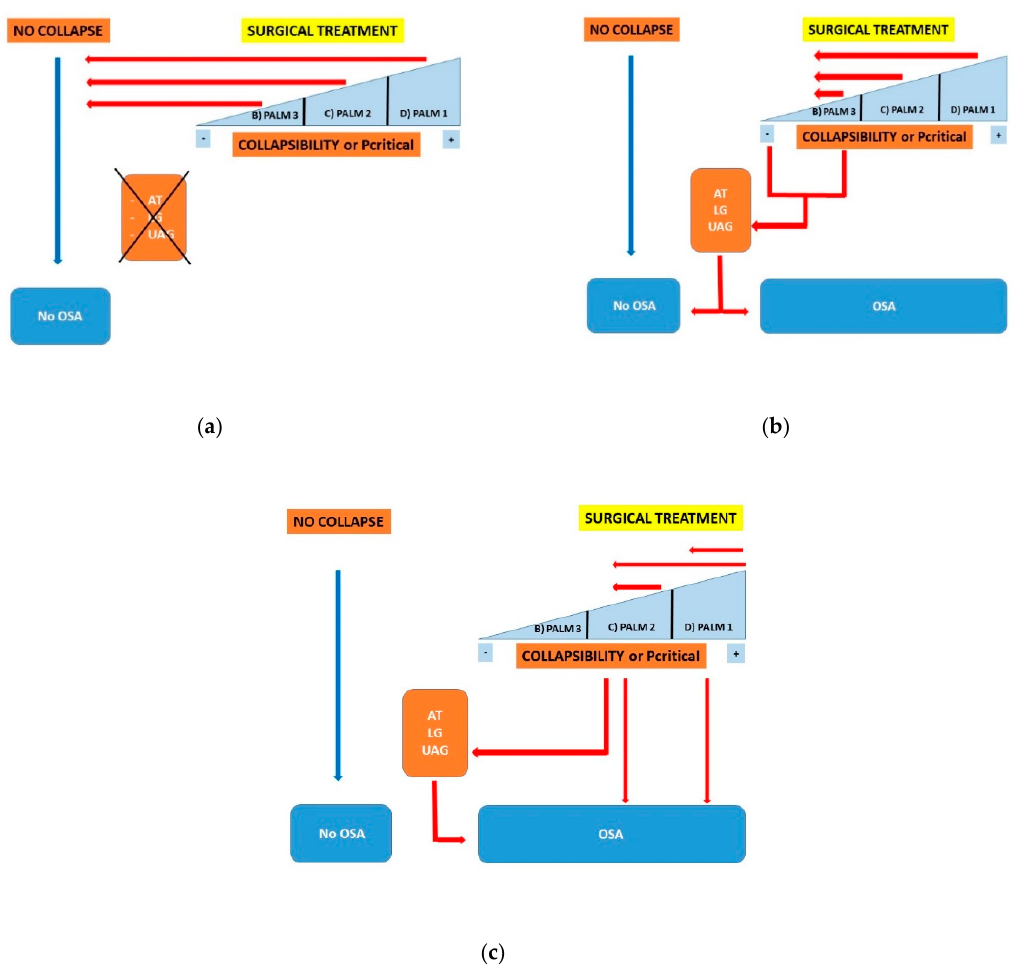
Figure 2. ( a ) Surgical treatment of the upper airways (UA) achieves complete resolution of UA collapsibility, and the patient is cured independent of any other pathophysiological trait (PT) grade. ( b ) Surgical treatment of the UA significantly improves pharyngeal collapsibility up to a low grade of collapsibility. In this model, any complete resolution of apneic events or the persistence of OSA are caused by confounding PT. ( c ) Surgical treatment of the UA does not achieve any significant improvement of pharyngeal collapsibility, which remains of high grade, and obstructive sleep apnea (OSA) does not improve. Legend: PALM: Pcrit, AT: arousal threshold; LG: loop gain; UAG: upper airway gain; OSA: obstructive sleep apnea, PT: pathophysiological